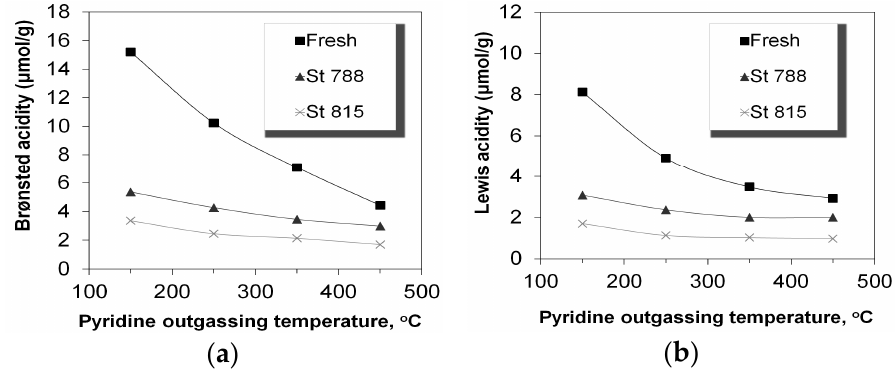
Figure 3. Acidity of the P/ZSM-5 additives: ( a ) Brønsted and ( b ) Lewis determined by FTIR-pyridine measurements at increasing pyridine equilibration temperature.